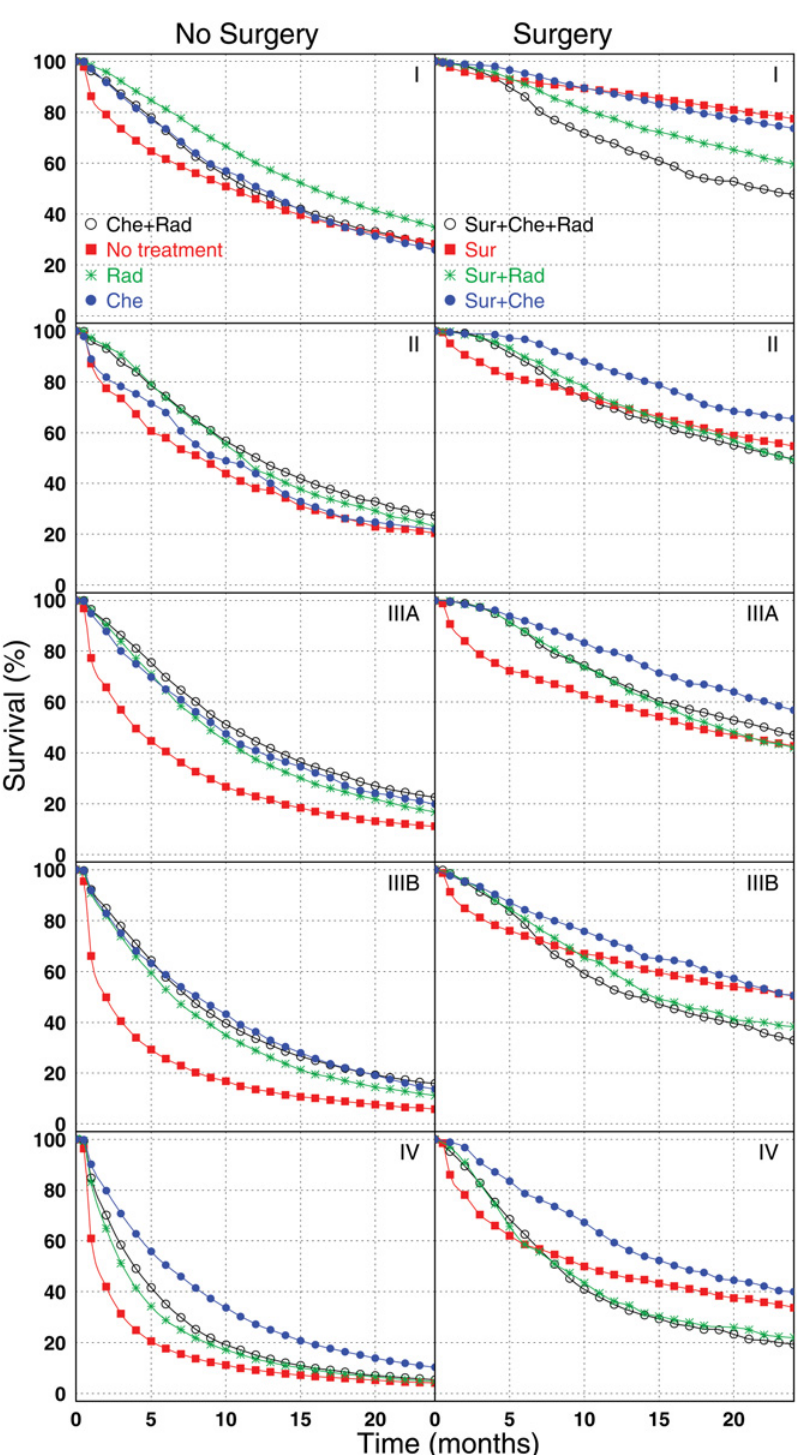
Fig 1. Survival curves for treatment-specific and stage-specific patient groups. Rows correspond to stages I, II, IIIA, IIIB, and IV.